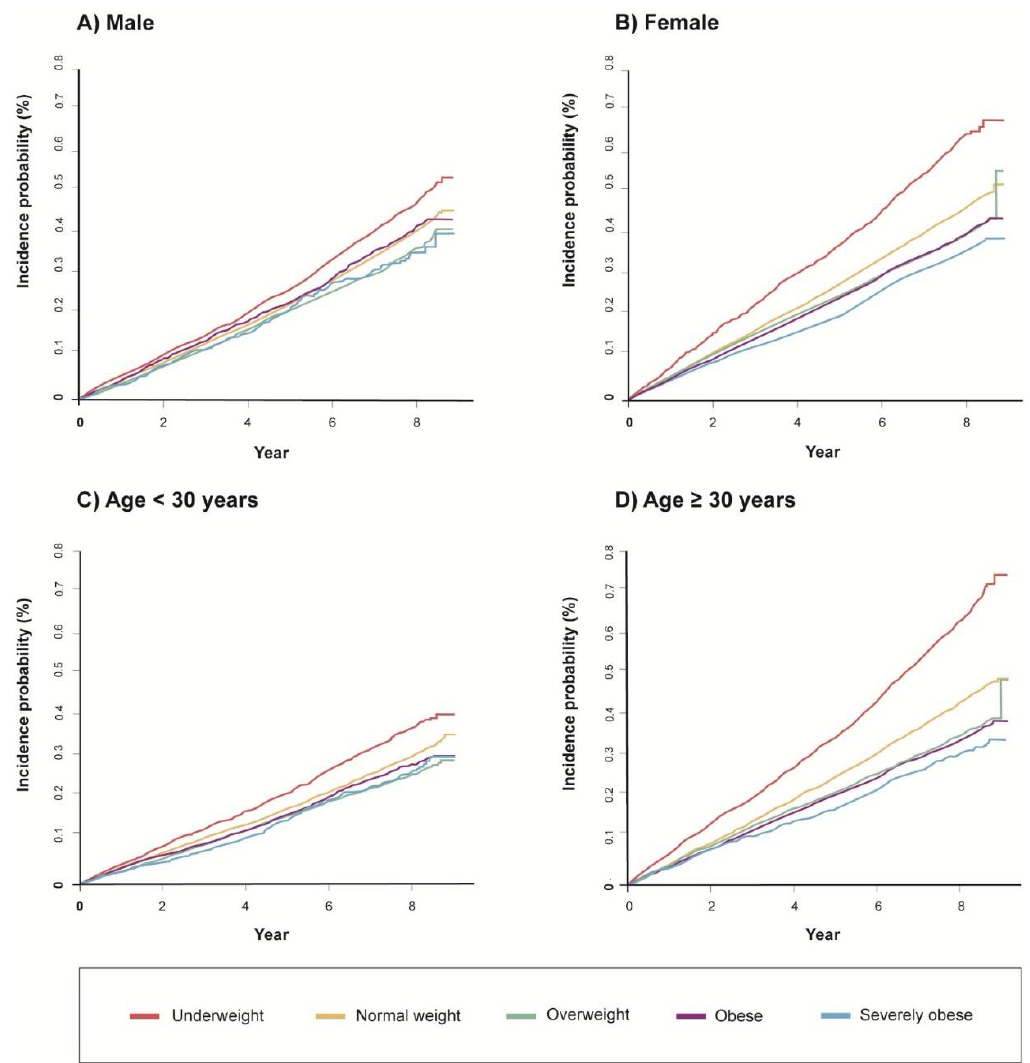
Figure 3. Cumulative incidence of bronchiectasis according to sex and age (%). ( A ) males, ( B ) females, ( C ) age <30 years, ( D ) age ≥30 years.